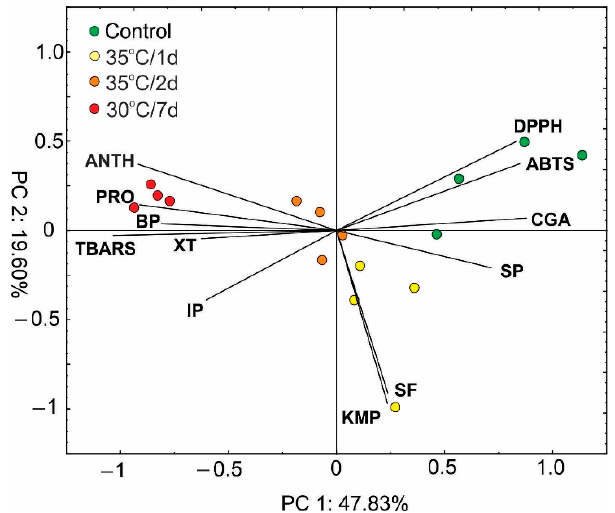
Figure 6. Scaled scatter plot of the principal component analysis of selected secondary metabolites, antioxidant capacity, proline, and the lipid peroxidation level (ANTH—anthocyanins; antioxidant capacity (ABTS, DPPH), BP—bergapten; CGA—chlorogenic acid; IP—isopimpinellin; KMP— kaempferol; PRO—proline; SP—soluble phenols; SF—soluble flavonols; TBARS—thiobarbituric acid reactive substances; XT—xanthotoxin). The length of the lines shows a correlation between original data and the factor